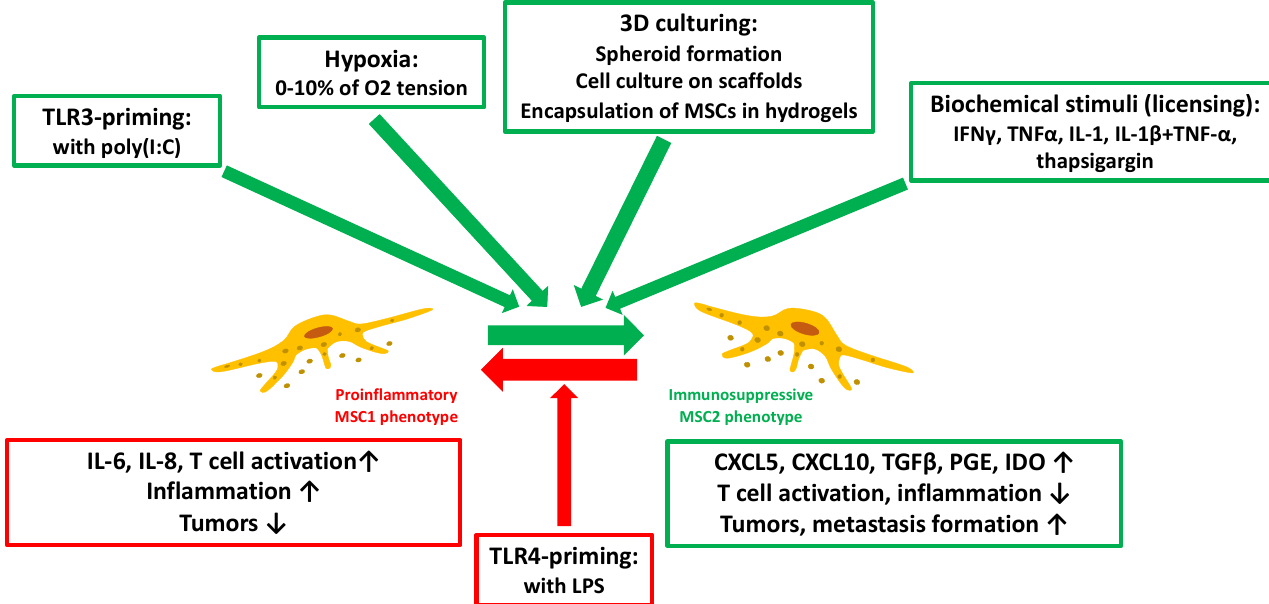
Figure 3. The modes and biological effects of MSC-secretome manipulation. Methods marked with green and green arrows favor the appearance of the MSC2 immunosuppressive phenotype. The method marked in red and the red arrow promote the MSC1 proinflammatory phenotype (TLR: Toll-like receptor; poly (I:C): polyinosinic:polycytidylic acid; 3D: 3 dimensional; MSC: mesenchymal stem cell; IFN: interferon; TNF: tumor necrosis factor; IL: interleukin; LPS: lipopolysaccharide; CXCL: C-X-C motif chemokine ligand; TGF: transforming growth factor; PGE: prostaglandin E; IDO: